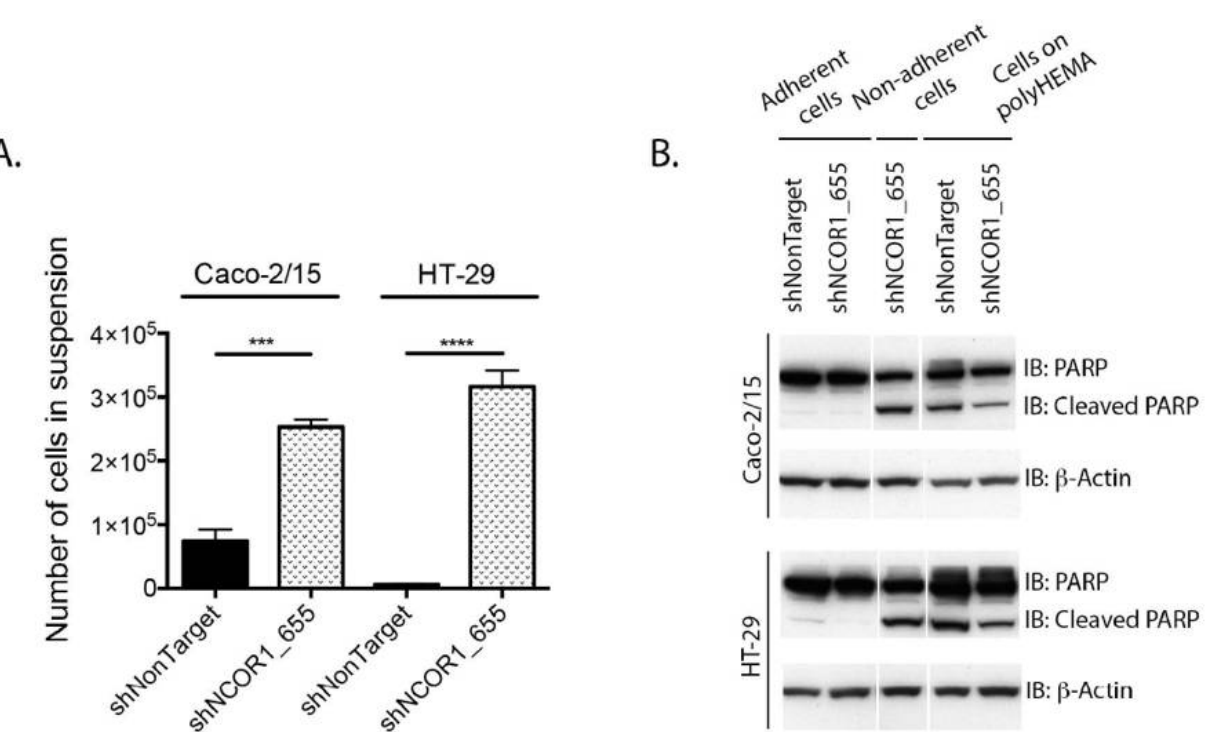
Figure 3. NCOR1 downregulation leads to reduced adhesion of CRC cells. ( A ) Total count of cells in suspension was done 16 h after seeding 1 × 10 6 cells per condition ( n = 3; means ± SEM). Student’s t -tests were used to measure the significance of the results (*** p < 0.001; **** p < 0.0001). ( B ) Immunoblots were performed to detect the complete and cleaved portions of PARP-1. Immunoblots were carried out with total protein extracts of Caco-2/15 and HT-29 cells obtained from plastic- adhered cells, cells in suspension (16 h after seeding), or cells that were seeded on petri dishes covered with polyHema ( n = 3). The relative level of β-actin for each sample was assessed to control for protein loading.